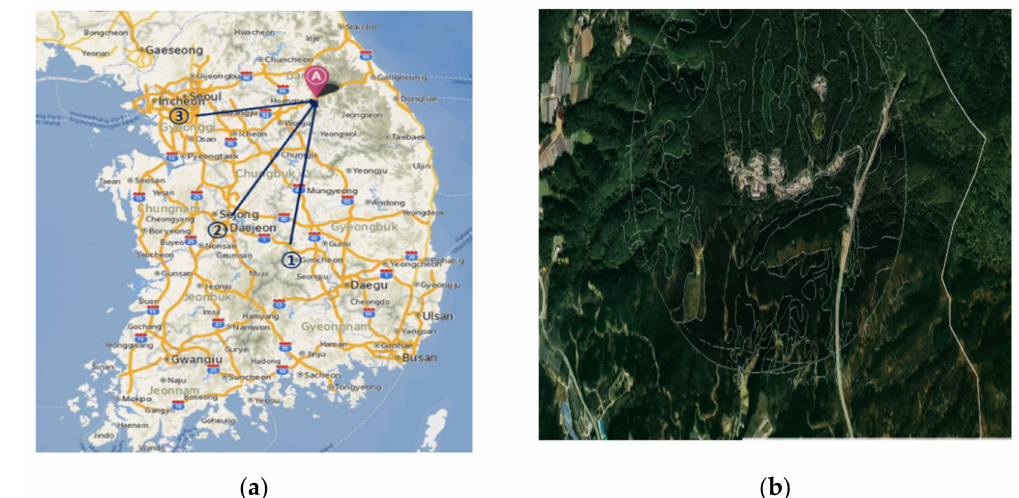
Figure 2. Maps of the study site. ( a ) Site location. Point A is Heongseong SoopChewon, and Points 1, 2, and 3 are the three cities from where the participants came. ( b ) Aerial photographs of Heongseong SoopChewon.